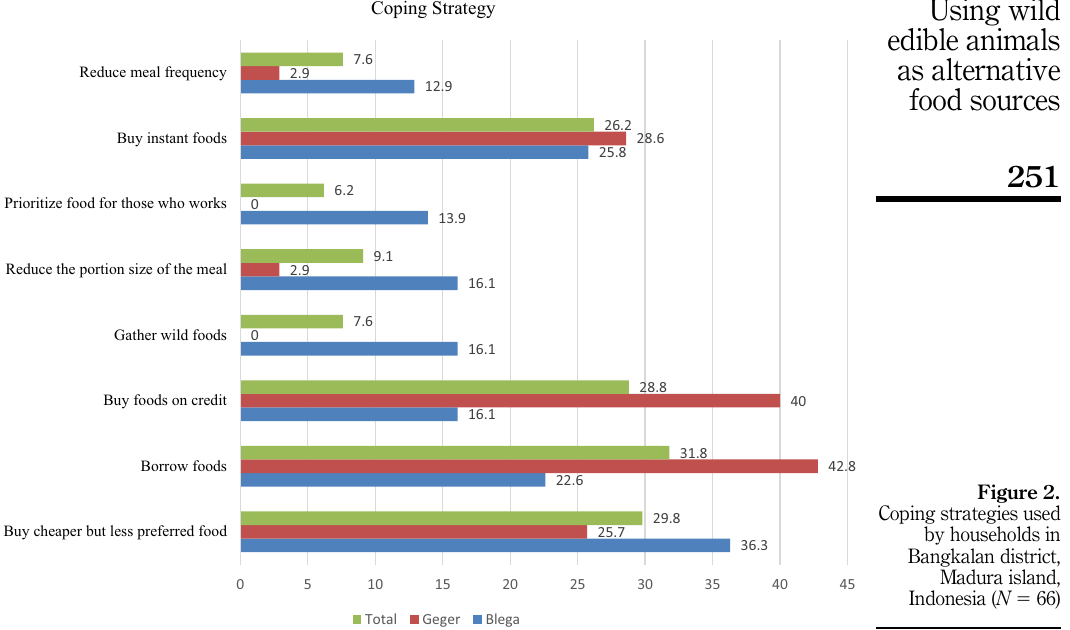
Figure 2. Coping strategies used by households in Bangkalan district, Madura island, Indonesia ( N 5